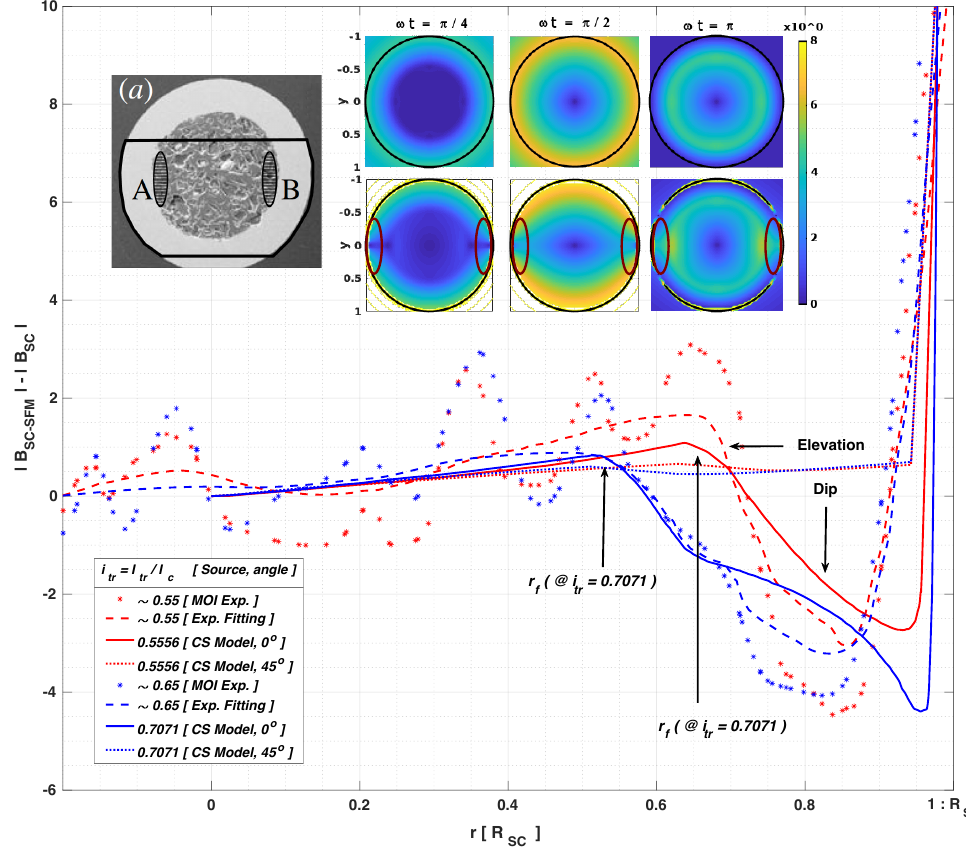
Figure 4. Magnetic flux difference between an SC wire of radius R SC and the equivalent SC-SFM metastructure with R SFM = 1.5 R SC in units of ( µ 0 /4 π ) J c R SC . Solid and dotted lines show the numerical results obtained by the extended CST along two different radial directions, being 0 ◦ the line over the x -axis at y = 0 in Figure 1, and 45 ◦ the xy − plane diagonal. Two set of curves are shown corresponding to self-field conditions with I tr = I c sin ( ω t ) , when ω t = 3 π /16 and π /4 (i.e., I tr / I c (cid:39) 0.5556 and 0.7071, respectively). For qualitative comparison, solid symbols and dashed lines show the raw and segmented-regression fitted data extracted from MOI measurements [39,41,43,80] reported for the Fe-sheathed MgB 2 monocore displayed at the subplot (a), where the ovals highlight the regions were an anomalous “elevation” and “dip” of the magnetic flux have been observed. All other insets show the calculated 2D local distribution of magnetic flux density at different instants of the AC current for the SC (top) and SC-SFM (bottom) wires. Equally sized ovals as in (a) are displayed, highlighting thence how the extended CST allows a straightforward explanation of the non-conventional patterns for the local magnetic flux density in the SC-SFM